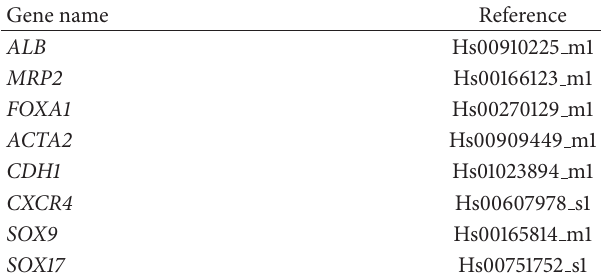
Table 2: Primers used for FL-MSC mRNA